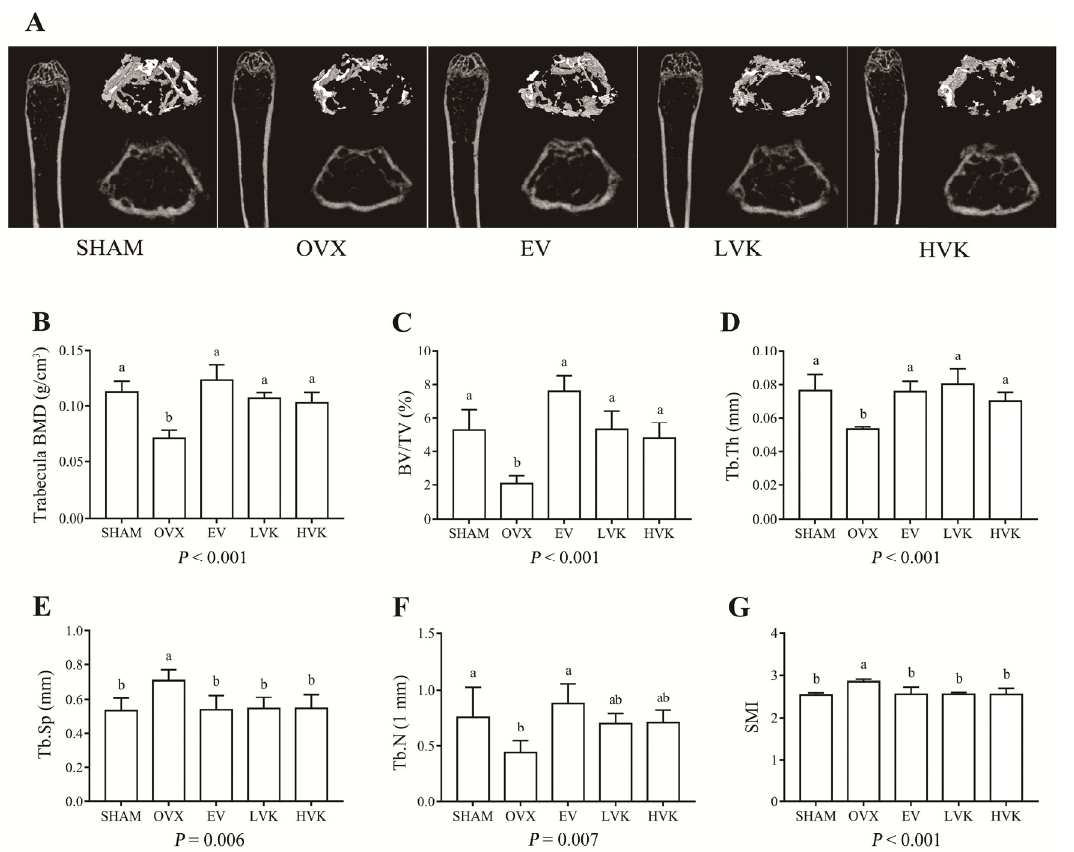
Figure 3. Bone microstructures in mice that were sham operated or ovariectomized and untreated or administered EV, LVK, or HVK for 12 weeks. Representative micro-CT images of the 3D reconstruction of distal femurs and cross sections ( A ). Quantitative analysis of the BMD, BV/TV, Tb.Th, Tb.Sp, Tb.N, SMI of trabecular bone by micro-CT ( B–G ). Values are mean ± SD, n = 5 per treatment. Labeled without a common letter means a significant difference, p < 0.05. BMD, Bone mineral density; BV/TV, percent bone volume; EV, estradiol valerate; HVK; MK-4 40 mg/kg body weight group; LVK, MK-4 20 mg/kg body weight group; MK-4, menaquinone-4; OVX, ovariectomized group; SD, standard deviation; BMD, bone mineral density; BV/TV, percent bone volume; Tb.Th, trabecular thickness; Tb.Sp, trabecular separation; Tb.N, trabecular number; SMI, structure model index.